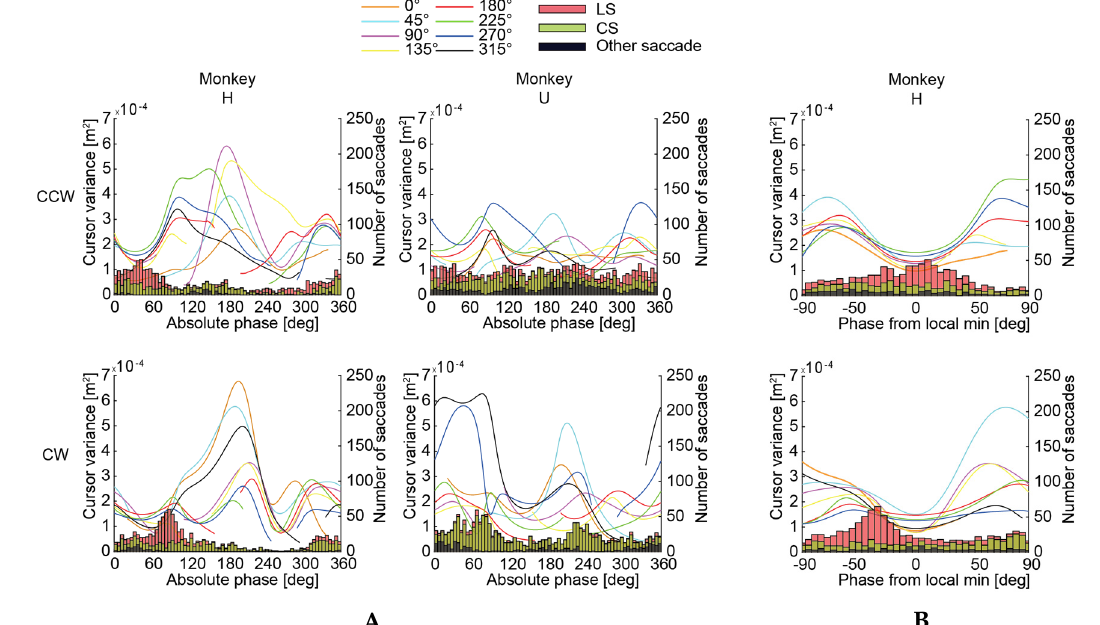
Figure 6. Relationships of the cursor positional variance and gaze points directed by saccades in between (within 45°–315° phase range relative to the start point) the start and target points in the circle-drawing task are shown. ( A ) The relationships are plotted in absolute phase (phase in polar coordinates with its origin at the center of the monitor). Cursor variance and number of each saccade are indicated by the solid lines and bars, respectively. Note that the cursor variance gets local minimum at the phase of around 30°–60° for almost all starting point regardless of the rotational directions in Monkey H . ( B ) Gaze points directed by saccades are plotted against the local minimum phase of the cursor variance in Monkey H (a negative sign is assigned to the phase when the gaze leads the cursor movement). Bin width is 5° in all the panels.